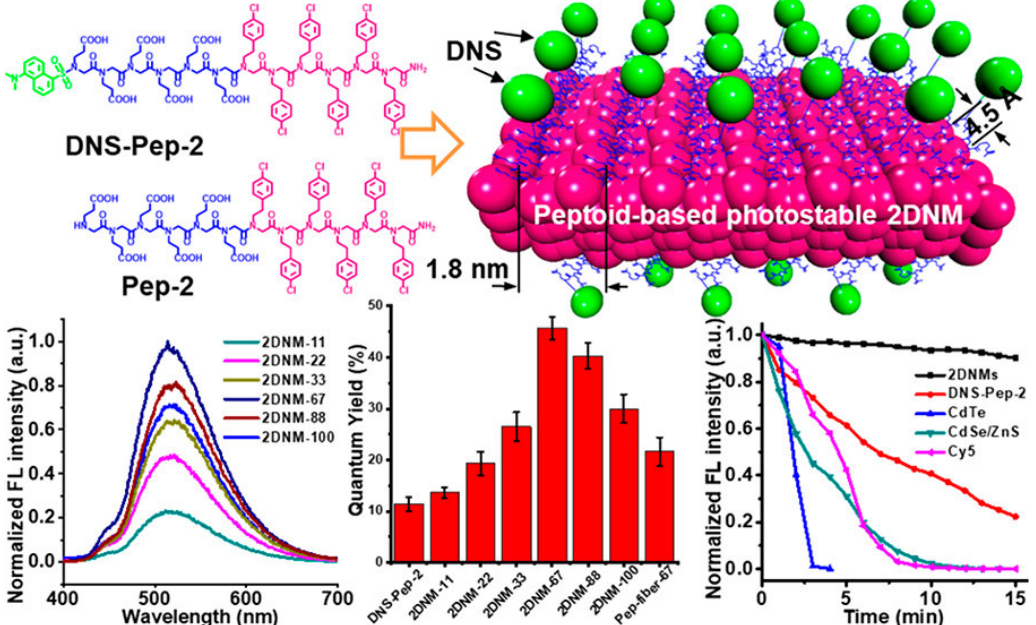
Figure 4. Peptoid-based fluorescent and crystalline 2D nanomembranes (2DNMs). Peptoid structures and a scheme showing the 2DNM formation, in which the peptoid hydrophobic domain, polar domain, and dansyl (DNS) dye are highlighted in red, blue, and green colors, respectively (Adapted from ref. [34]. Copyright 2021, American Chemical Society).